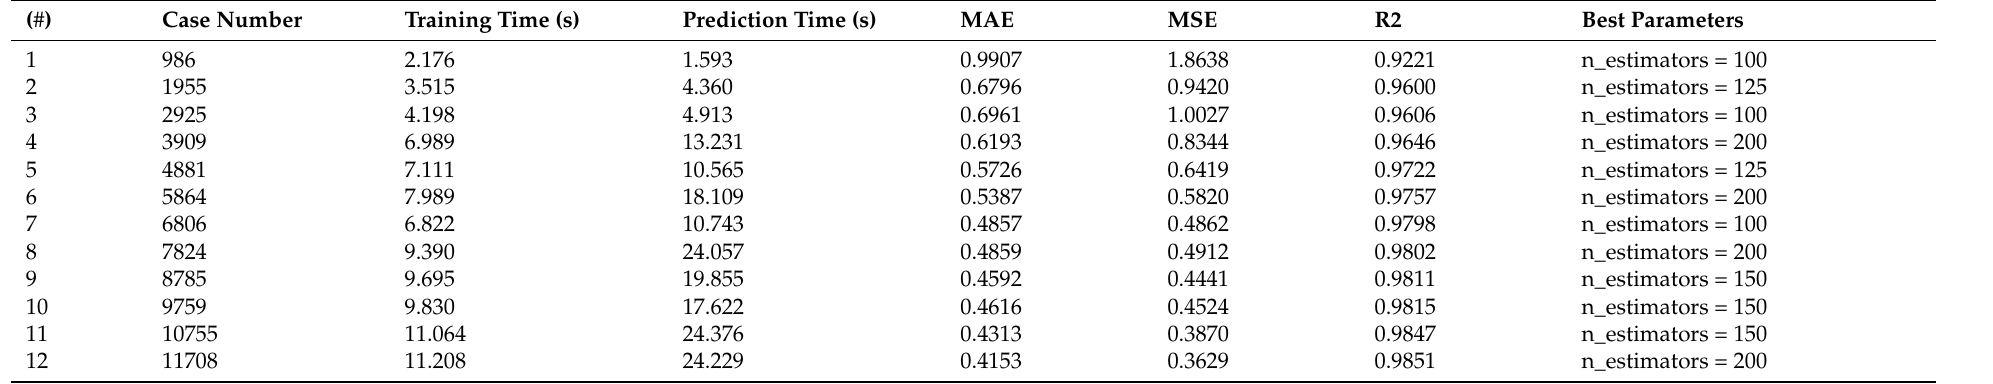
Table A4. Results of running the model with: